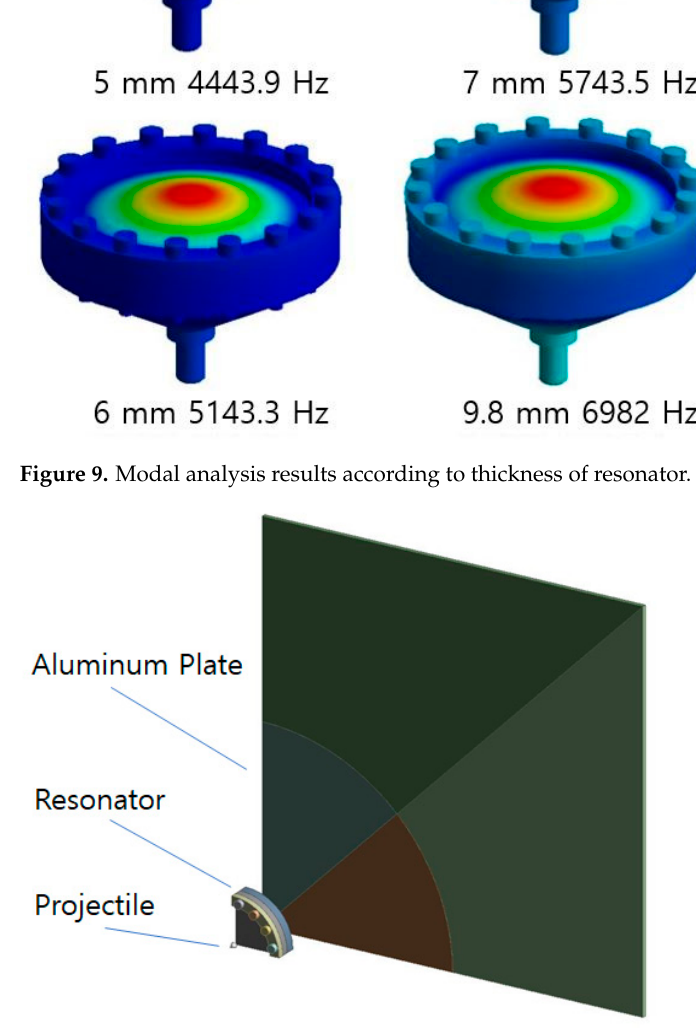
Figure 10. Numerical analysis model.